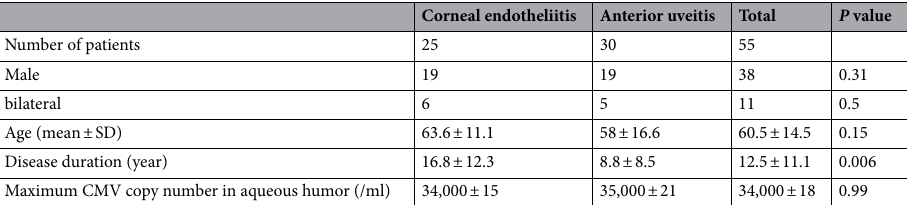
Table 1. Patient Characteristics of corneal endotheliitis and anterior uveitis by cytomegalovirus infection. Values were shown as mean ± standard deviation. Copy number was calculated after Log